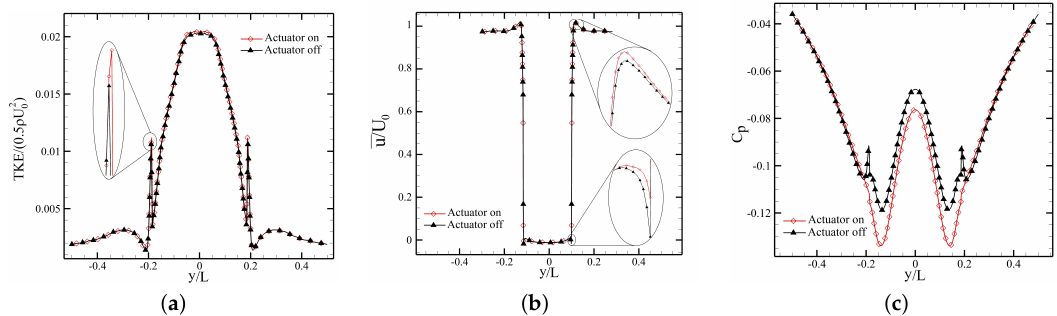
Figure 17. ( a ) Turbulent kinetic energy, ( b ) streamwise velocity and ( c ) coefficient of pressure for case 5 at x / L = 0.001, z / L = 0.15 (near wake) and Re = 2.25 × 10 5